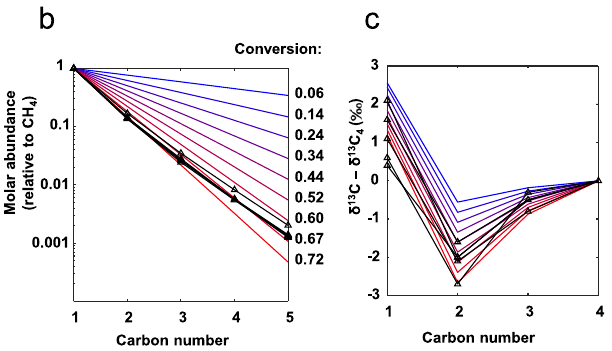
Fig. 2 Numerical simulation on the distributions of abundance and δ 13 C of short alkanes from hydrogen biodegradation of long alkyl chains. a Reaction scheme showing that the number of carbon and hydrogen atoms contributed by the alkyl chain and H 2 to the gaseous alkanes depends on C – C cleavage positions. Brown, blue, and red represent cases of 1, 2, and 3 capping hydrogen atoms donated by H 2 , respectively. b Numerical simulation on the abundances of gaseous alkanes relative to CH 4 . c Numerical simulation on δ 13 C of gaseous alkanes relative to δ 13 C nC4H10 . Legend of b and c : black lines — Kidd Creek gas (samples with both δ 13 C and gas content data) 4,5 ; blue, red, and gradient colours in between — modelled results (Eqs. 4 – 7) with conversion (fraction of CH 4 -contained 12 C atoms in all 12 C atoms) labelled in panel b . KIE parameters (identical for hydrogenolyses on kerogen side chains and on alkanes): primary 13 C KIE of 13 k / 12 k = 1.0015 (inverse KIE); secondary 13 C KIE of 13 k / 12 k = 0.9978